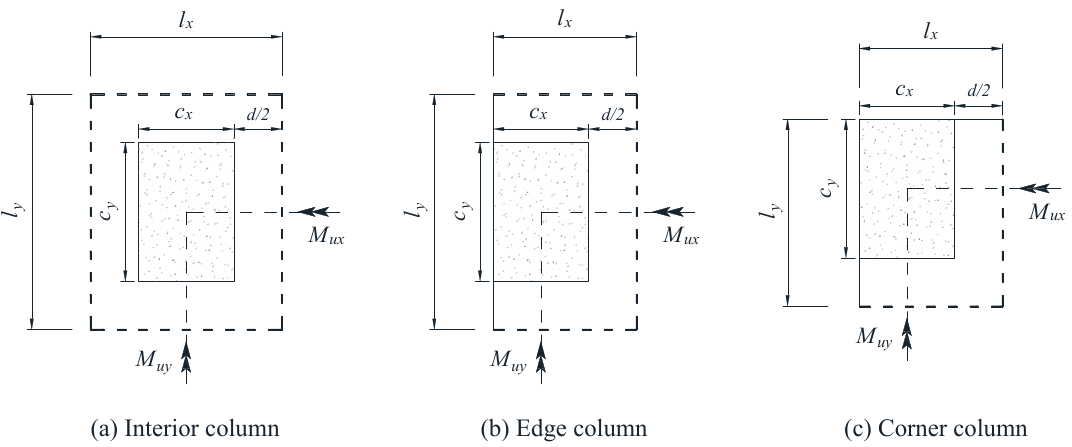
Figure 4. Definition of critical section. ( a ) Internal column, ( b ) Exterior column and ( c ) Corner